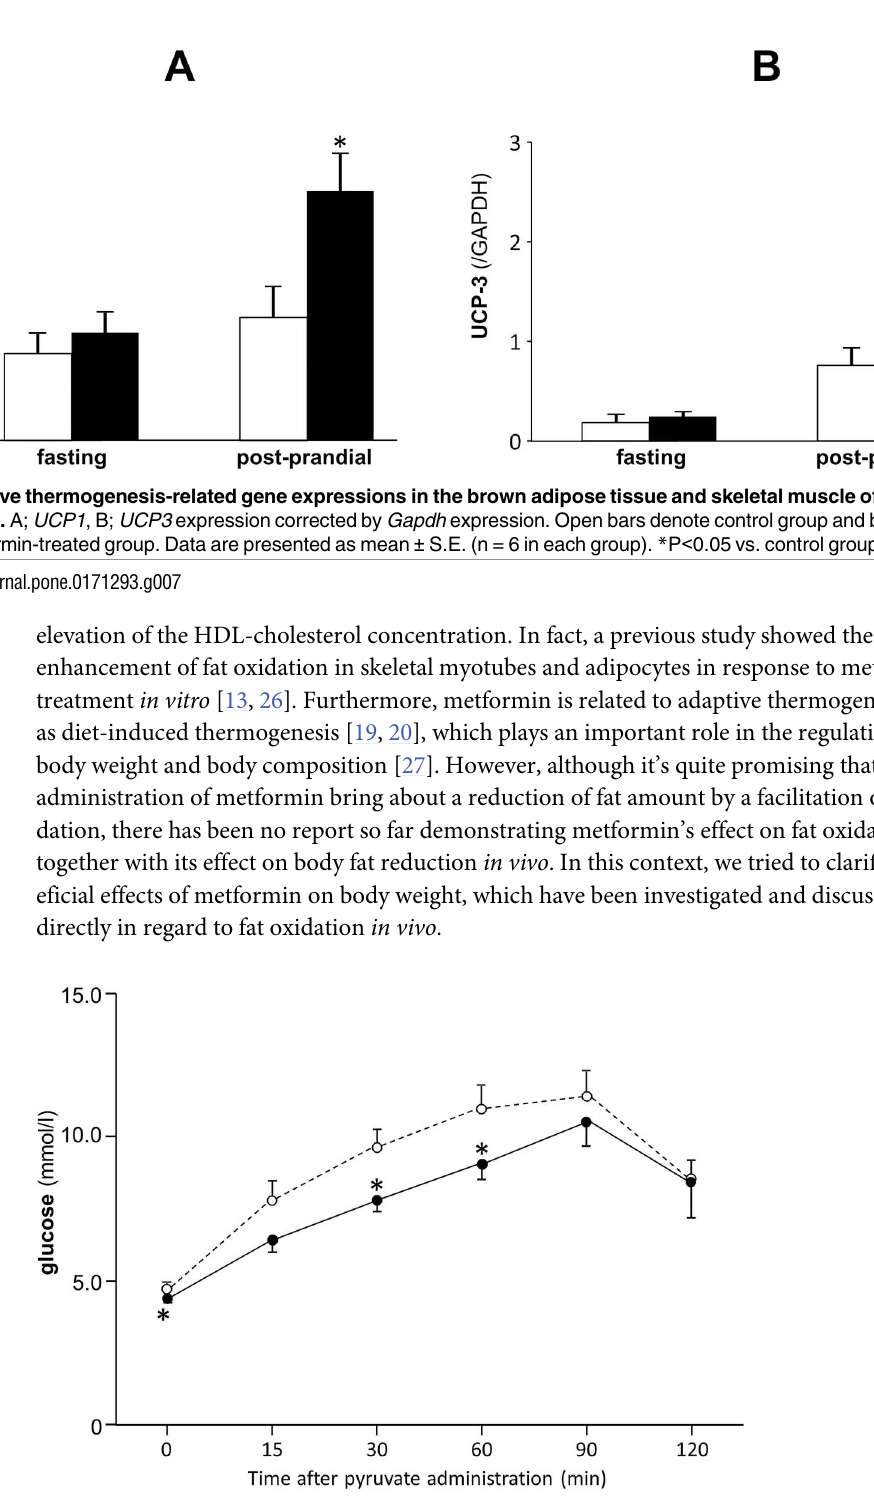
Fig 8. Pyruvatetolerance test in SD rats at 15 weeks old. Data are presented as mean ± S.E. (n = 6 in each group). Paired t-test was used for the comparisonbetweengroups. Open circle and dotted line; control group, closed circle and solid line; metformin-treated group. * P < 0.05vs. the value of control group at each time